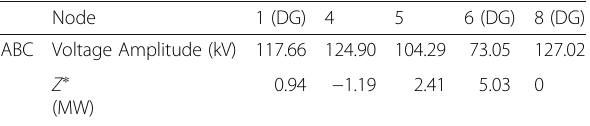
Table 4 Voltage amplitude and objection function values of key nodes (Fault 3) Node 1 (DG) 4 5 6 (DG) 8 (DG) ABC Voltage Amplitude (kV) 117.66 124.90 104.29 73.05 127.02 0.94 − 1.19